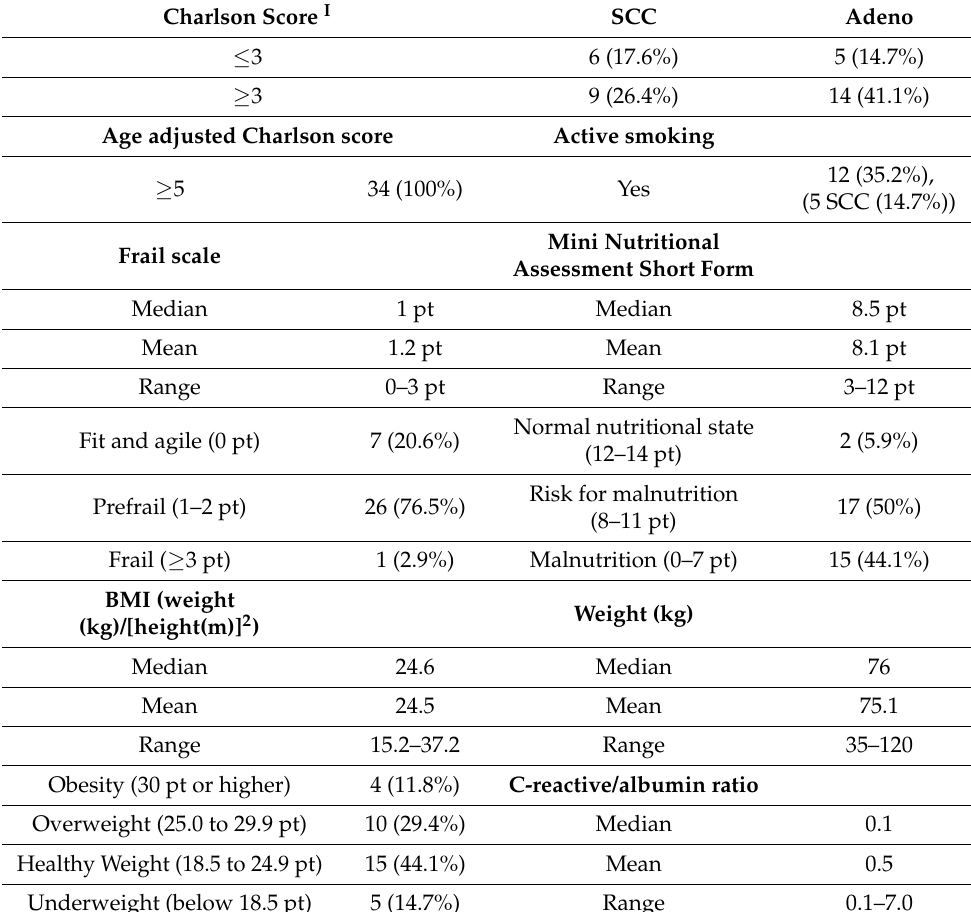
Table 2. (Geriatric and categorical) Screening score characteristics